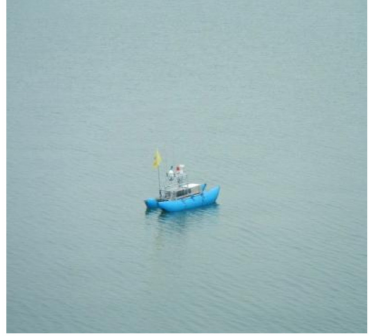
Figure 5. The unmanned surface vehicle “USBV”.